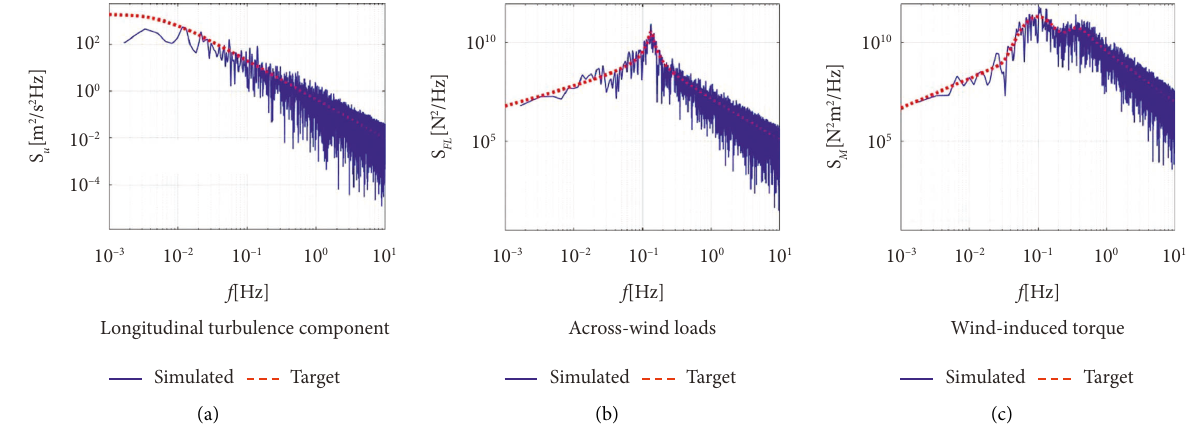
Figure 18: Power-spectral density functions at the rooftop H/sqrt(BD) � 8.